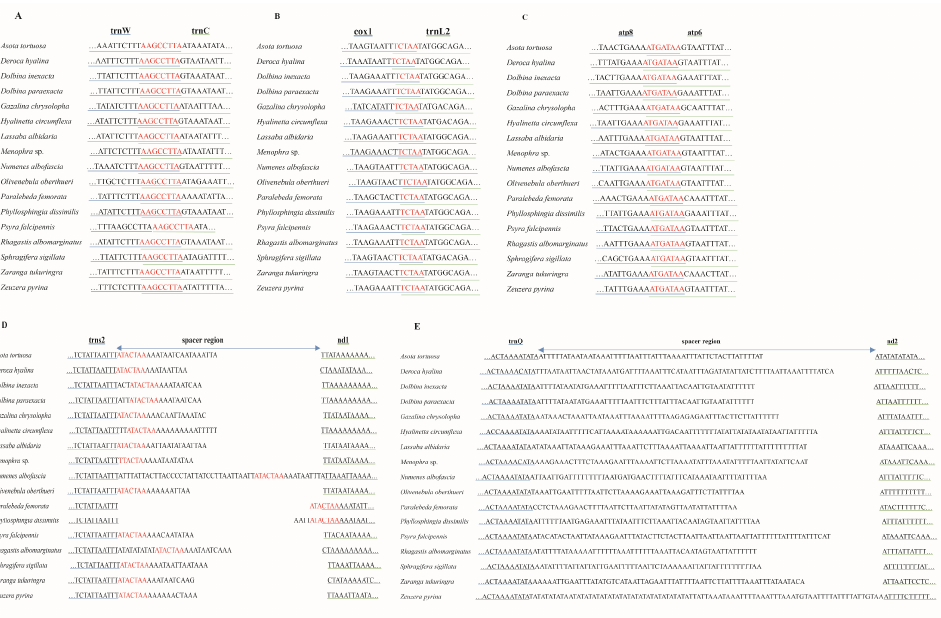
Figure 4. The overlapping region and spacers in 17 new mitogenomes. The underline color of genes is consistent with that of their corresponding sequences. ( A – C ) represent the overlapping region between trnW and trnC, cox1 and trnL2, and atp8 and atp6, respectively. The nucleotides marked red indicate the sequence of overlapping region. ( D ). The intergenic spacer between trnS2 and nd1. The nucleotides marked red indicate the conserved motif sequence. ( E ). The intergenic spacer between trnQ and nd2.